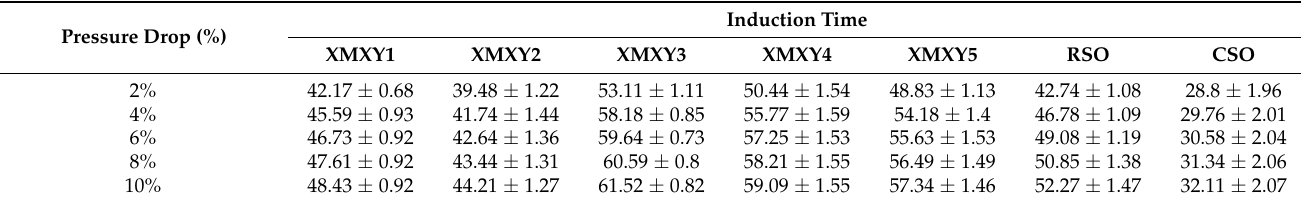
Table 2. Induction time of XMXY1–5, RSO, and CSO samples.